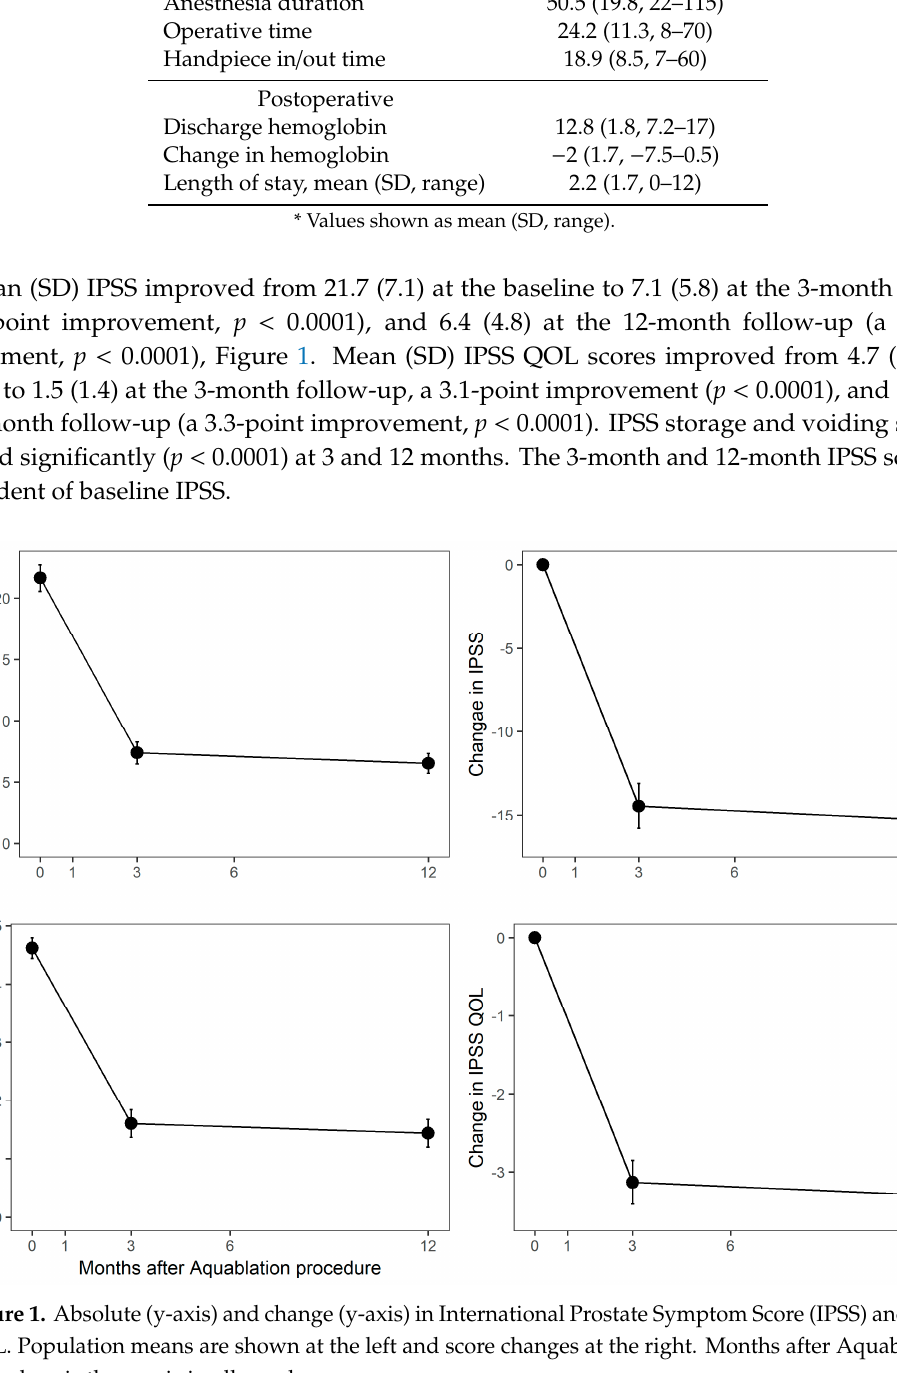
Table 2. Operative characteristics.